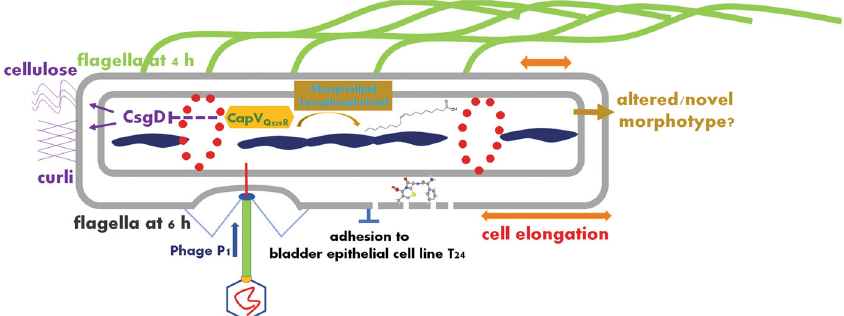
Fig. 9 Summary of morphological and physiological changes caused by the production of the patatin-like phospholipase variant CapV Q329R in E. coli . Overexpression of CapV Q329R in E. coli MG1655 causes substantial morphological and physiological changes which lead to cell elongation with extensive fi lamentation as a consequence, disparate FtsZ-ring formation, impaired nucleoid segregation, and condensation. a change in the overall lipid pro fi le of the cells, downregulation of fl agella expression and motility, downregulation of rdar bio fi lm morphology and production of its activator CsgD and enhanced susceptibility to infection by the myophage P1 and the cell wall inhibiting antibiotic cephalexine. In the clinical isolate E. coli No. 12, reduced adhesion to the bladder epithelial cell line T24 has been observed. In strains not producing the rdar morphotype at 37 °C, a potentially novel bio fi lm morphotype has been observed. Cephalexin structure from PubChem (https://pubchem.ncbi.nlm.nih.gov/compound/Cephalexin); structure of oleic acid from Wikipedia (https://en.